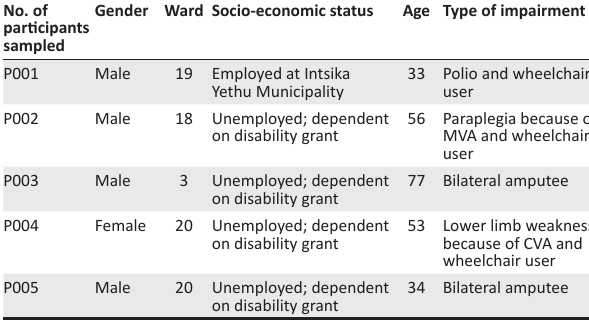
TABLE 1: Demographic details of